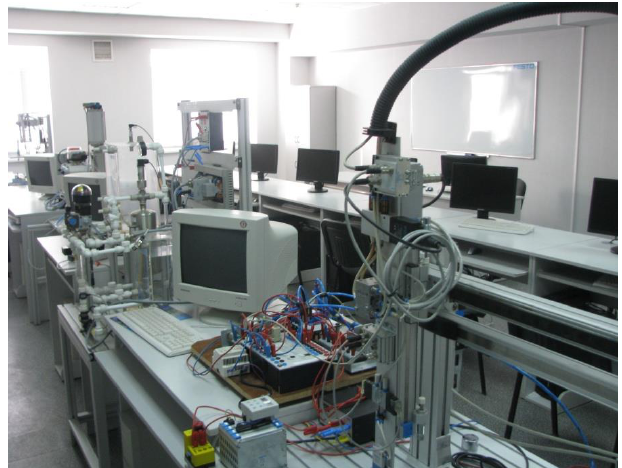
Figure 5. Control Systems